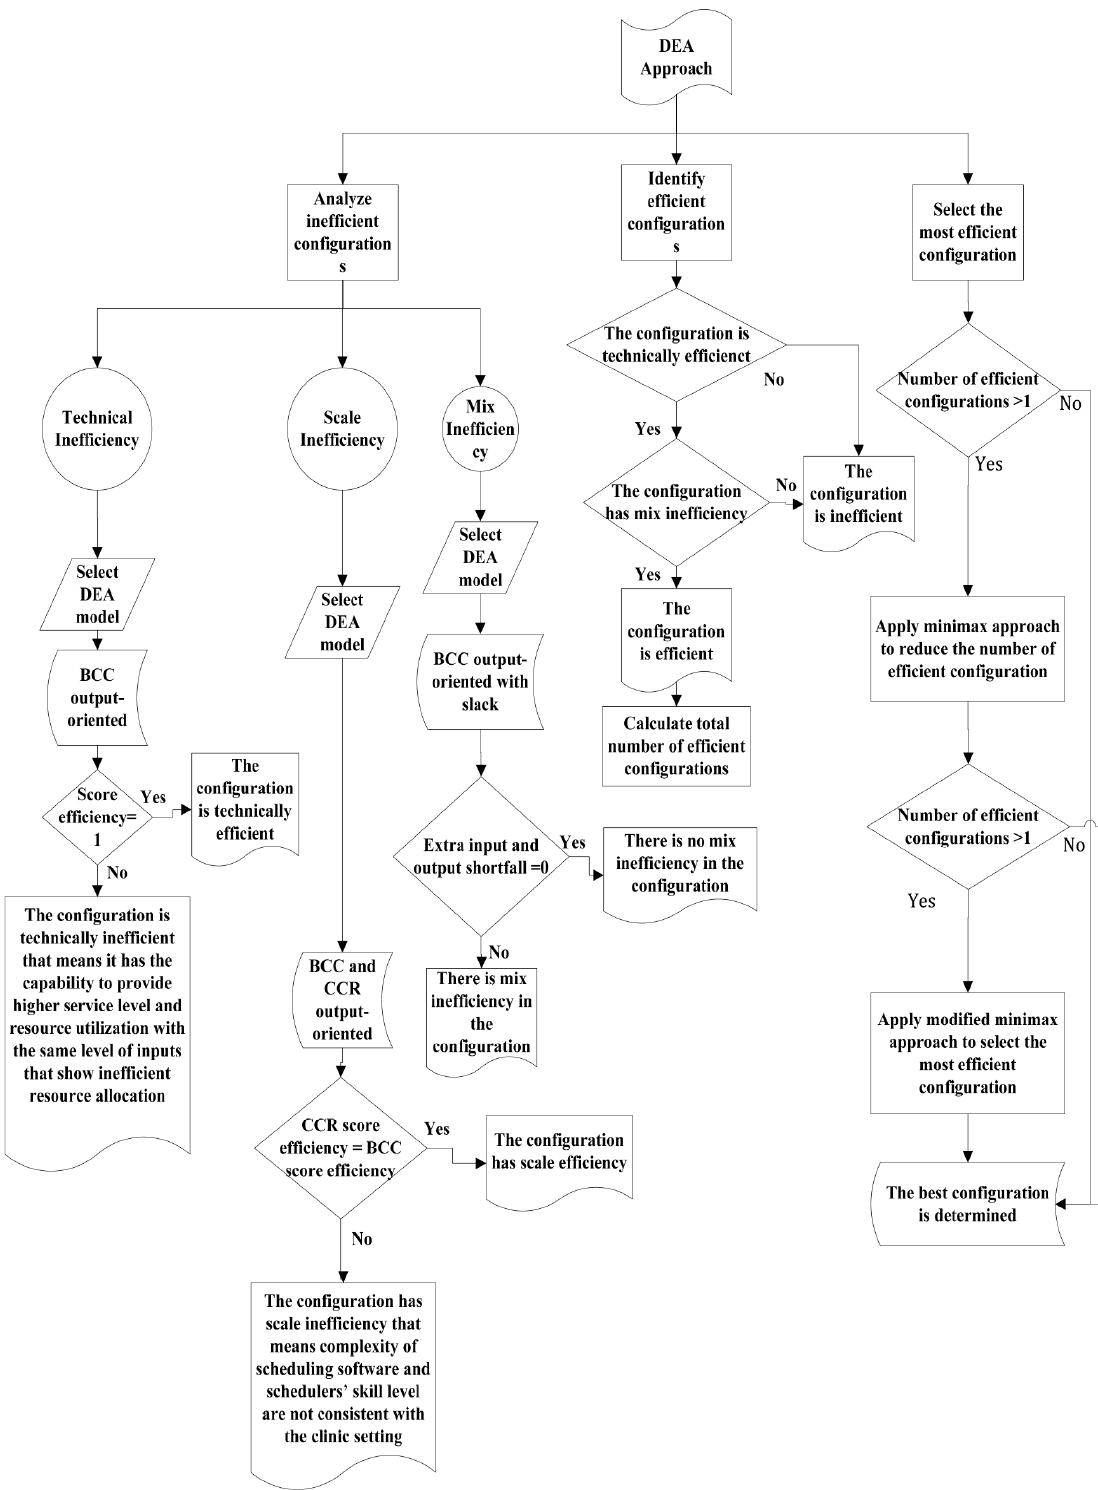
Figure 1. DEA approach